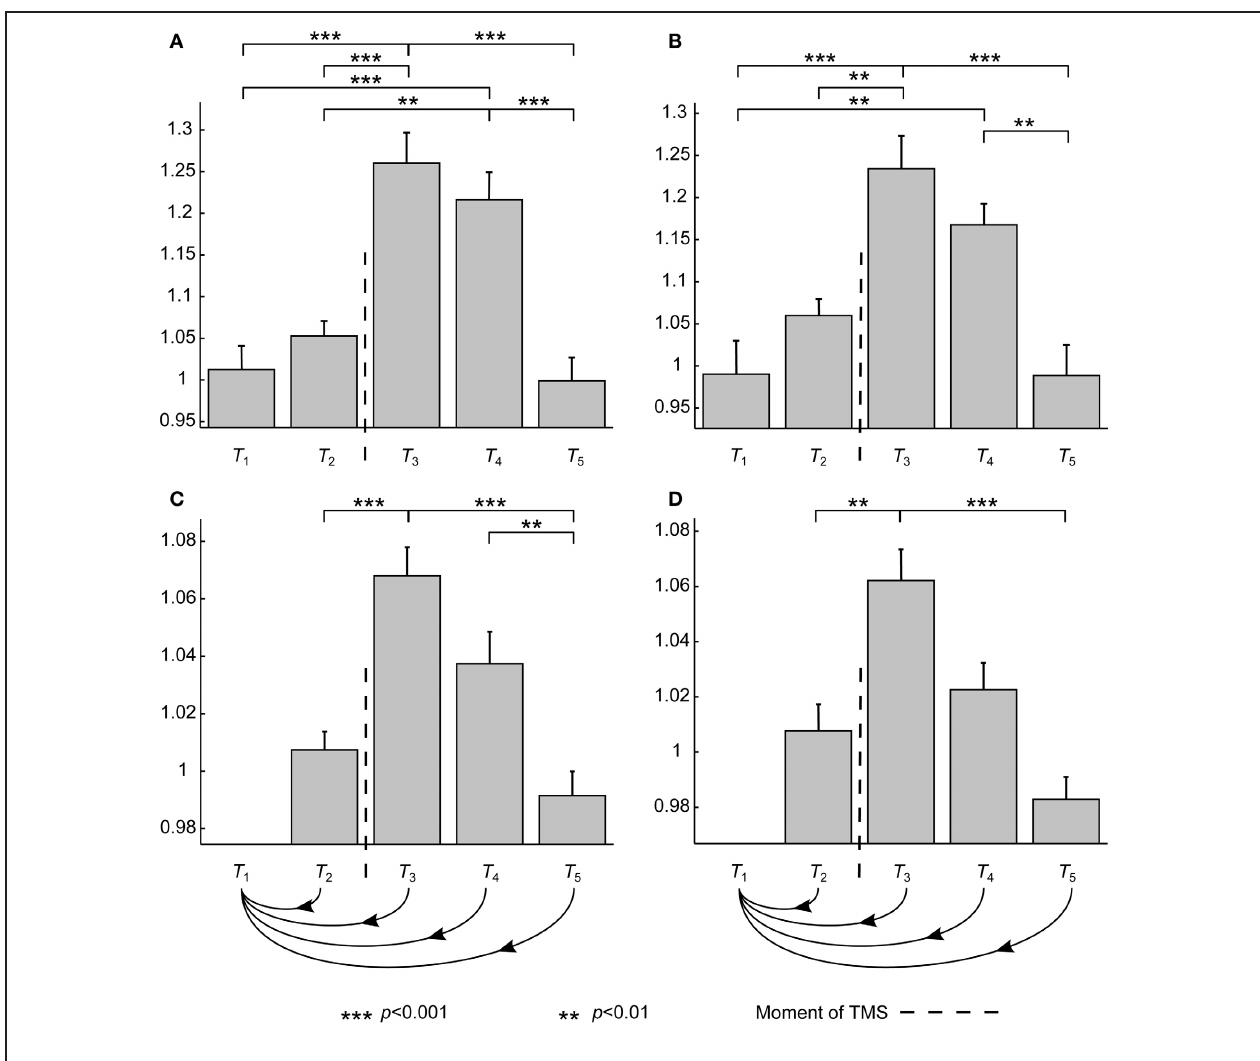
FIGURE 2 | The results averaged over subjects. The asterisks show statistically significant differences between different conditions after the post-hoc tests. Error bars show ± standard-error-of-the-means calculated over datasets. Vertical axes are dimensionless and show the differences with respect to the baseline. T 1 , T 2 , T 3 , T 4 , and T 5 refer to time intervals (in ms) [ − 200, − 100], [ − 100, 0], [15, 115], [115, 215], and